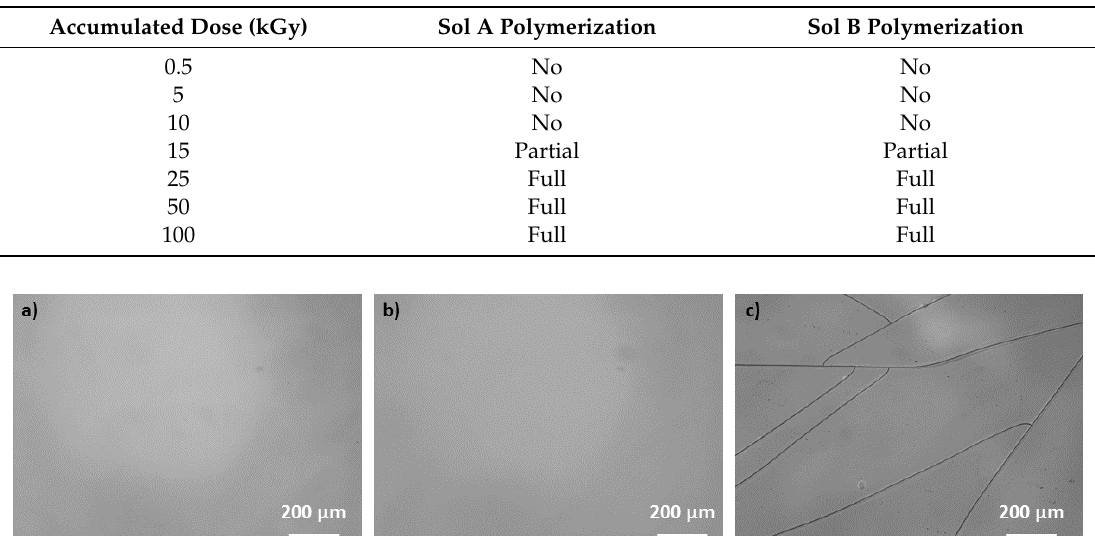
Table 1. E ff ect of X-ray accumulated dose (kGy) on the photopolymerization of sol A (photo-initiator) and B (photo-initiator free).